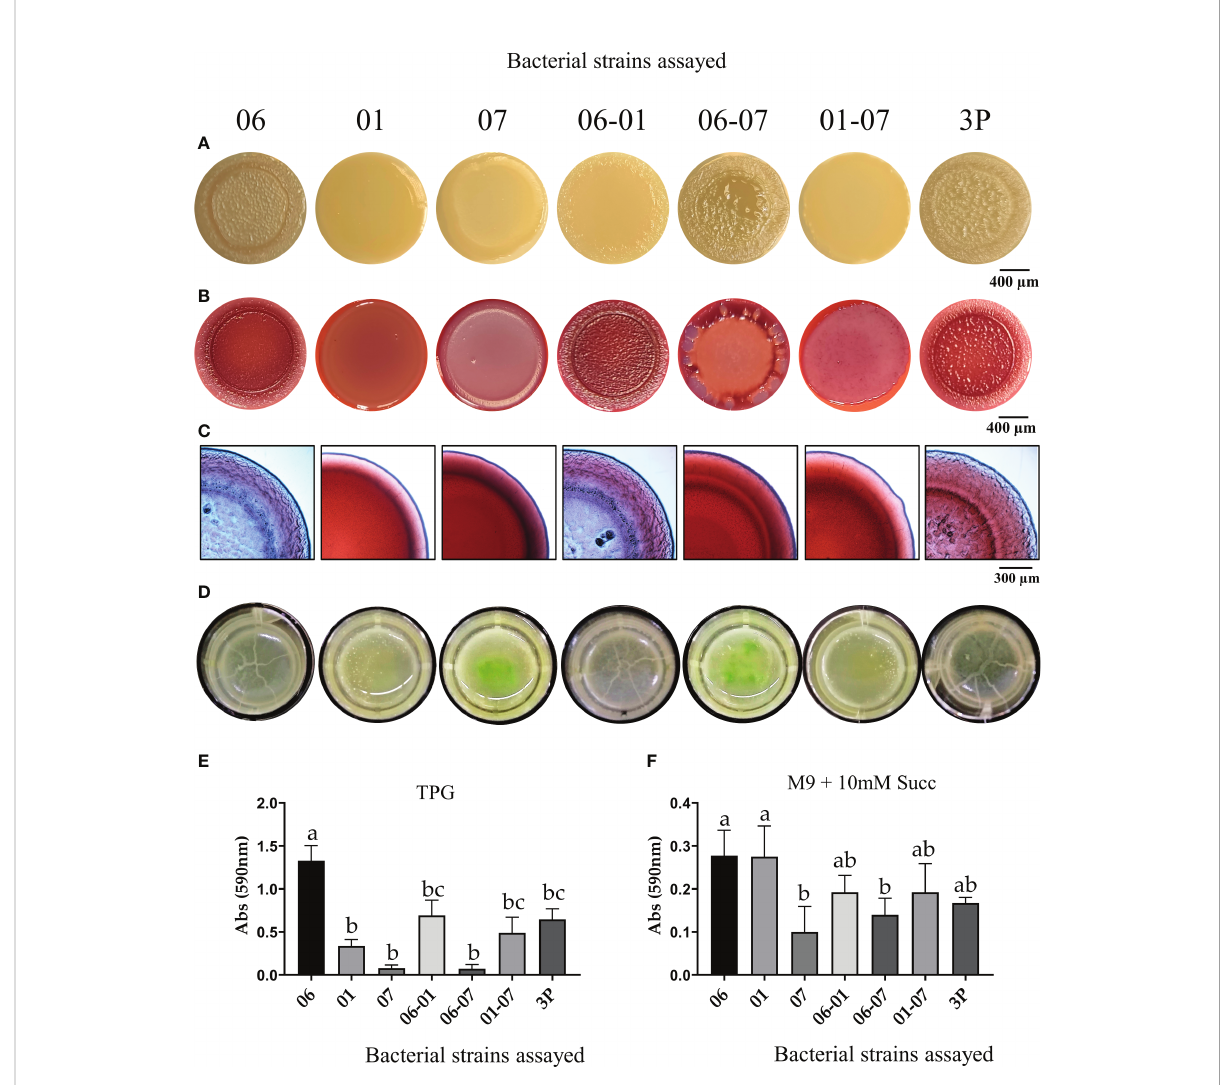
FIGURE 4 Colony morphology and bio fi lm formation of the individual strains and dual and triple strain combinations. Colony morphology growing after 5 days of incubation in (A) TPG, in (B) TPG plates supplemented with Congo red (40 µg/ml) and Coomassie brilliant blue (20 µg/ml). (C) Details of colonies grown on TPG supplemented with Congo red and Coomassie brilliant blue captured with a stereomicroscope. (D) Air-liquid interface pellicle formed after 5 days of incubation in TPG liquid media at 25°C. Single numbers correspond to single strain inoculation, and two numbers and 3P correspond to the dual and triple combinations of strains in the same proportion of 1:1 or 1:1:1, respectively. Average quanti fi cation and standard error of four independent experiments of bacterial adhesion are presented by measuring crystal violet absorbance at 590 nm in (E) TPG and (F) M9+succ. 01: P. chlororaphis PcPCL1601; 06: P. chlororaphis PCL1606; 07: P. chlororaphis subsp. piscium PCL1607; 3P: combination of the three Pc strains. Different letters represent a statistically signi fi cant difference after one-way analysis of variance, followed by Fisher ’ s least signi fi cance test (P =